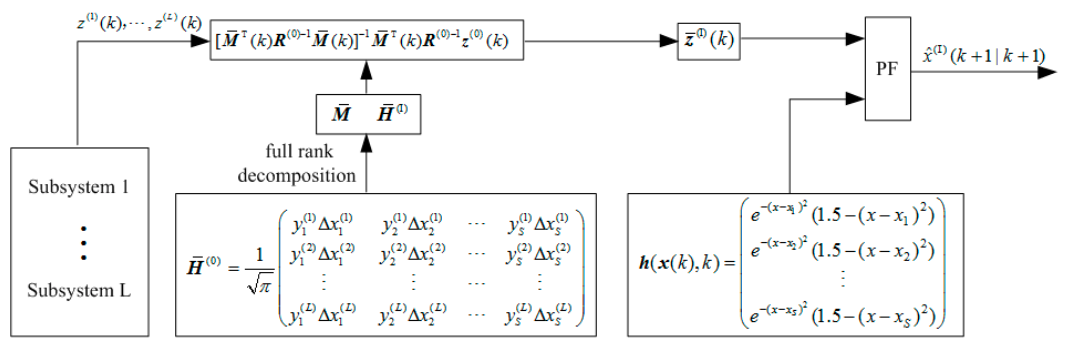
Figure 1. Flow chart of the weighted measurement fusion particle filter (WMF-PF) algorithm.